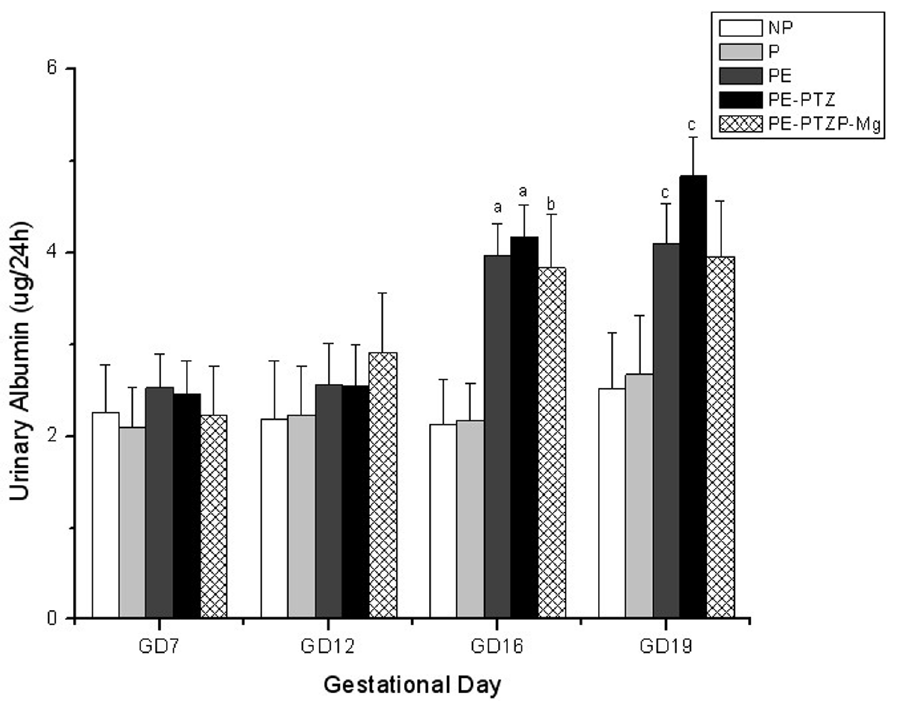
Figure 3. Twenty four-hour urinary albumin on different GDs. he 24-h urinary albumin was measured on GDs 7, 12, 16, and 19 using an automatic analyzer. The values are mean 6 SEM of the 24-h urinary albumin in each group (repeated measures analysis of variance). (a) P , 0.01, PE and PE-PTZ group vs. NP and P groups on GD 16. (b) P , 0.05, PE-PTZ-Mg group vs. NP and P groups on GD 16. (c) P , 0.05, PE and PE-PTZ group vs. NP and P groups on GD 19.